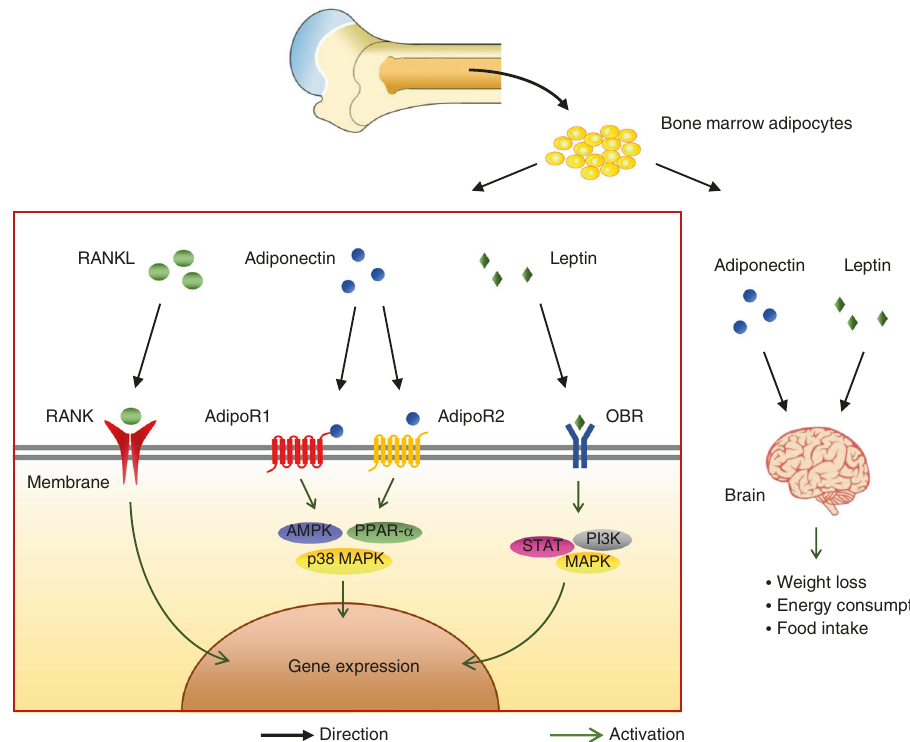
Fig. 4 MAT can secrete RANKL, the ligand of RANK. RANKL regulates metabolism by binding with RANK on the cell membrane. In addition, MAT can also secrete the adipokines leptin and adiponectin. Leptin and adiponectin combine with ADIPOR and OBR on the cell membrane of peripheral tissue, regulating cellular sugar metabolism. They also act on the central nervous system, leading to reduced food intake and energy